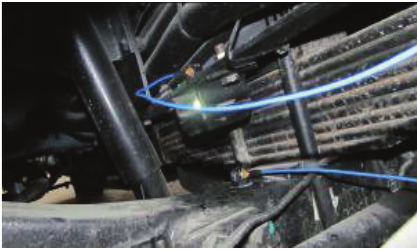
Figure 5: The FFT results of the pitch angular acceleration in the pitch